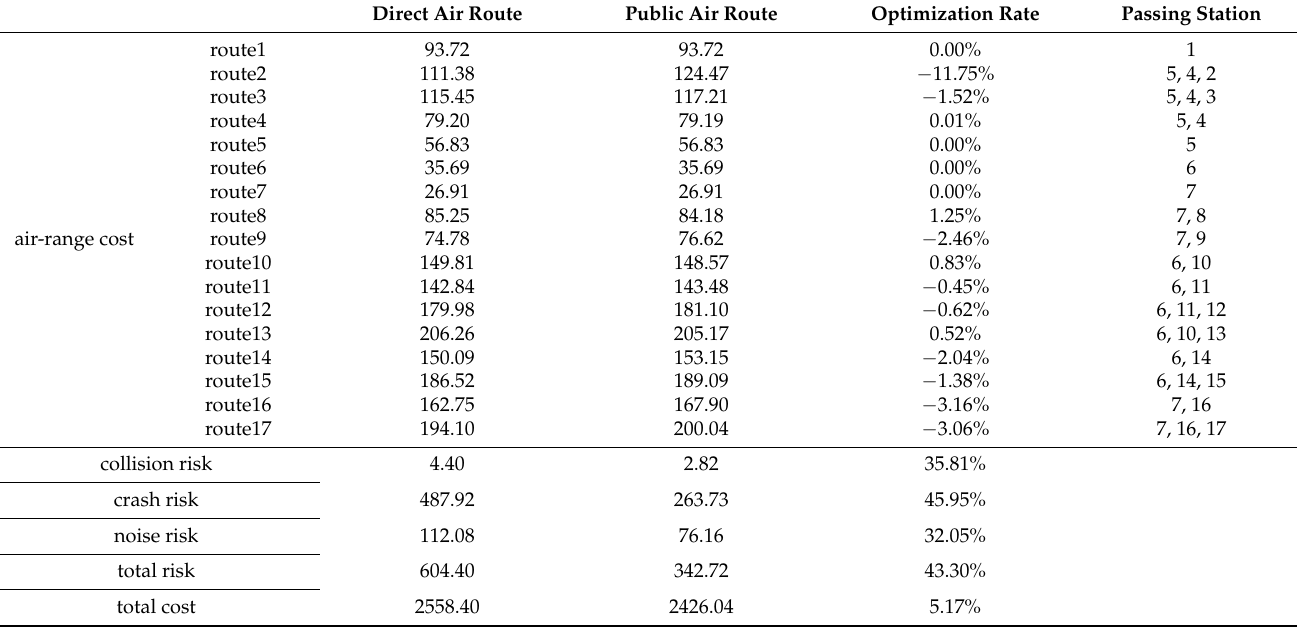
Table 8. Public air-route planning results.